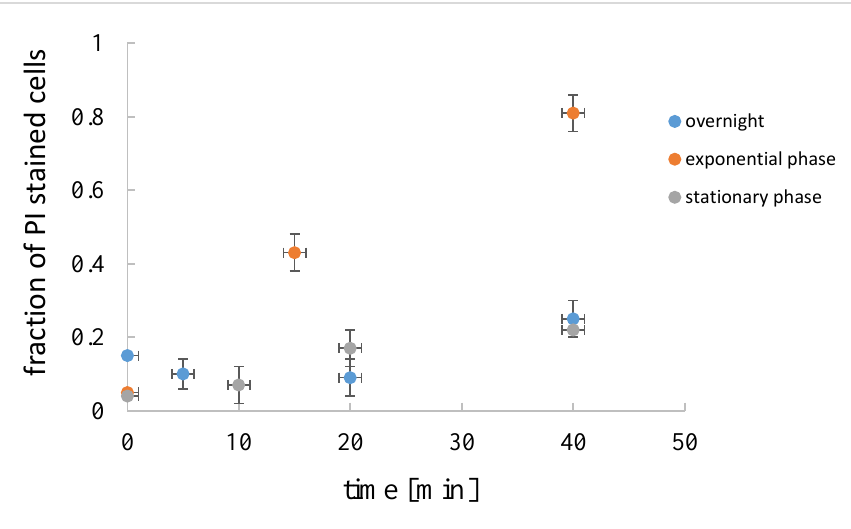
Figure 5. Fraction of dead cells (propidium iodide, PI, stained) in B. subtilis suspension at the beginning of the exponential growth (2.5 h of incubation, OD 650 = 0.5 a.u.), early stationary growth phase (5 h of incubation OD 650 = 0.6 a.u), and overnight culture (16 h of incubation, OD 650 = 0.8 a.u.) as determined under microscope. The fraction of dead cells in induced cell lysis at different physiological states are given at different times after cell lysis induction.